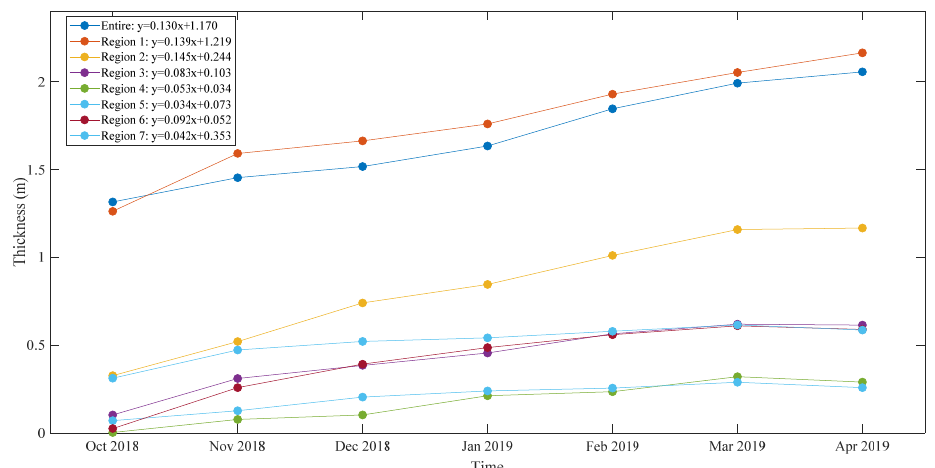
Figure 5. Mean sea ice thickness of the entire Arctic basin and seven regions for the 2018–2019 Arctic sea ice growth season.